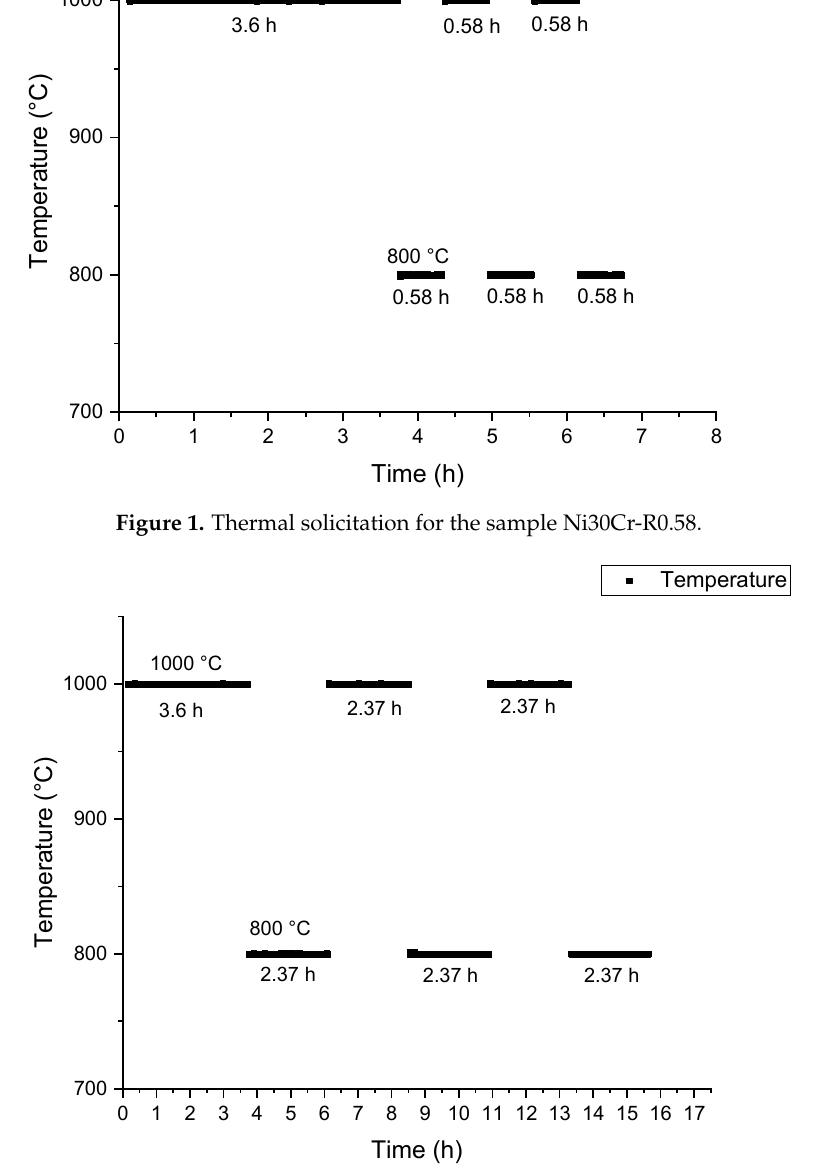
Figure 2. Thermal solicitation for the sample Ni30Cr-R2.37.